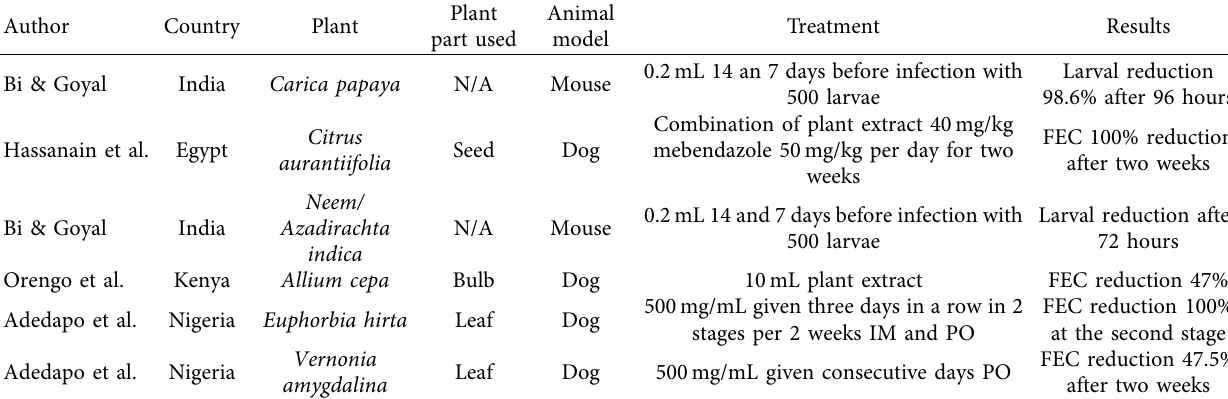
Table 2: In vivo studies on the effects of plants against Ancylostoma caninum